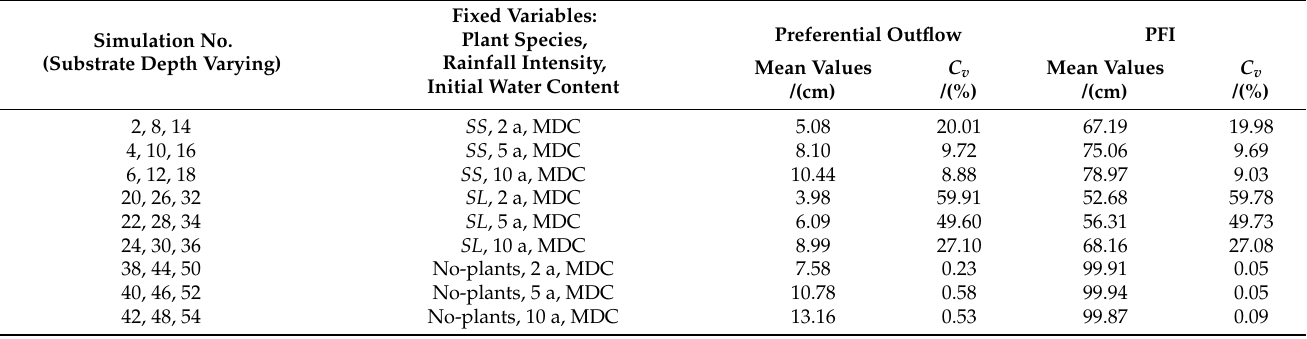
Table 10. Mean values and C v of PAS preferential outflow and PFI for different substrate